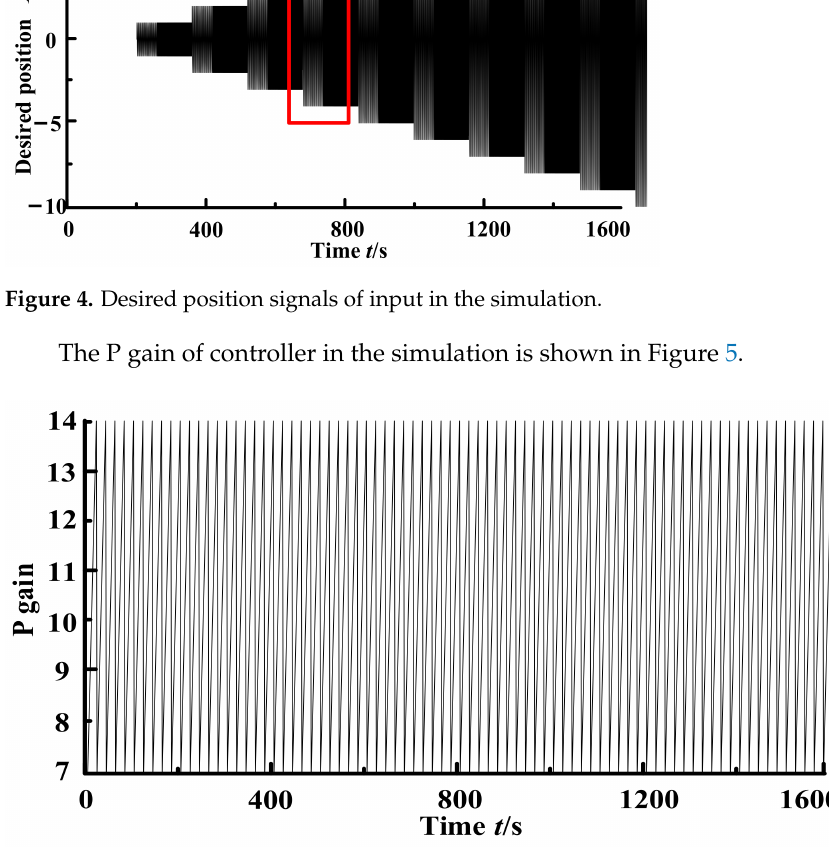
Figure 5. P gain of controller in the